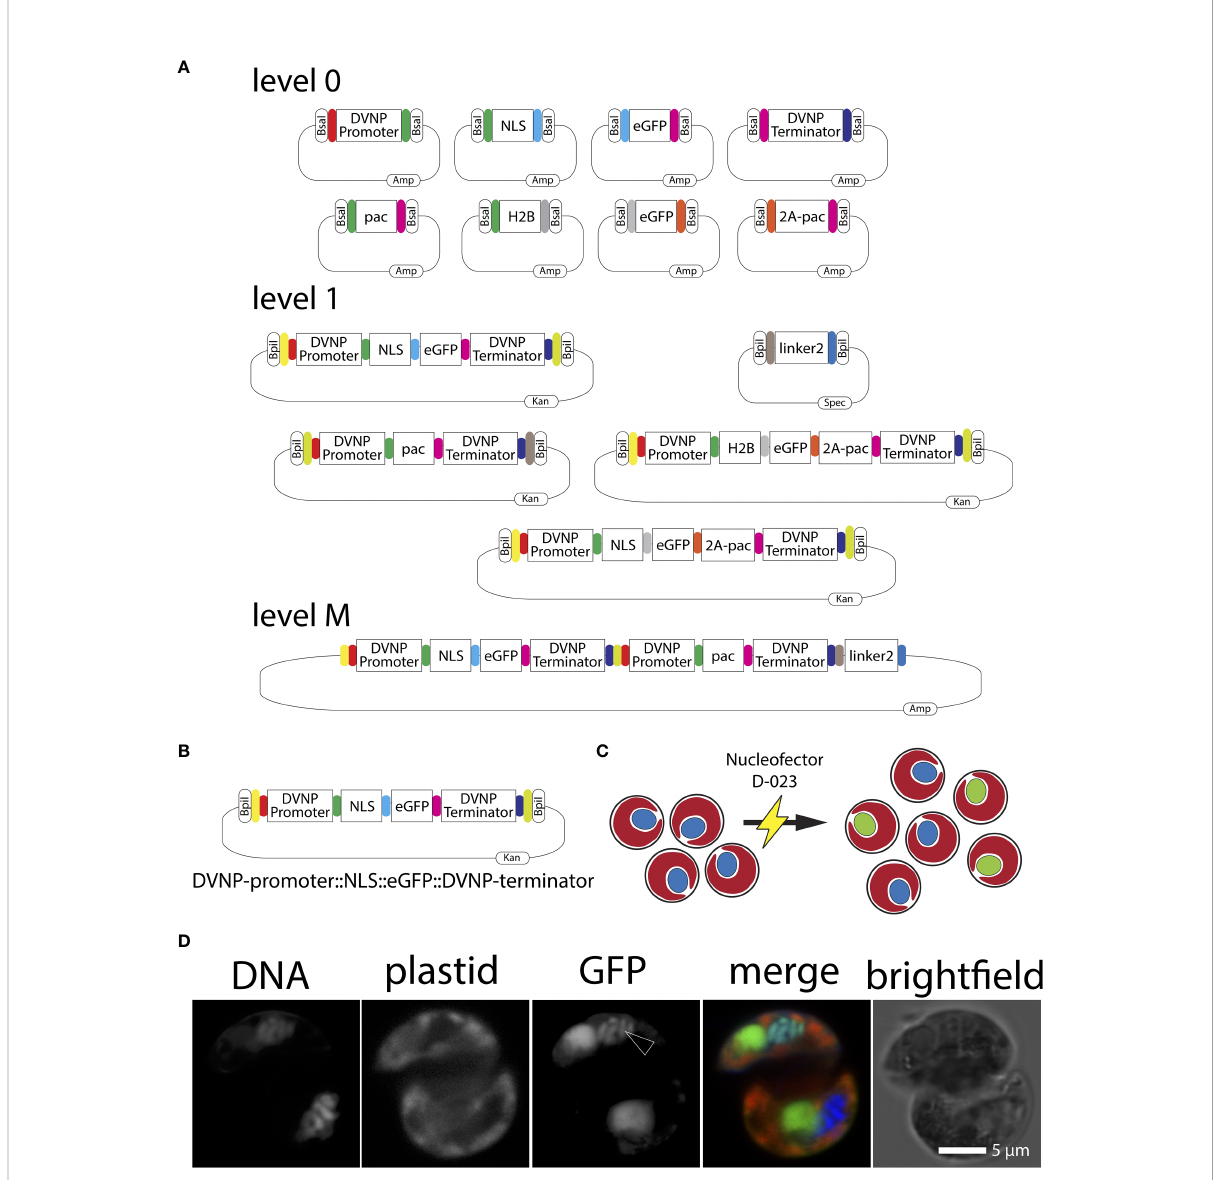
FIGURE 2 (A) Graphical representation of level 0, level 1, end-linker, and level M Golden Gate modules used in this study. Kan=kanamycin, Amp=ampicillin, Spec=spectinomycin. (B) Graphical representation of the DVNP-promoter::NLS::eGFP::DVNP-terminator level 1 position 1 module. (C) Cartoon depicting the Nucleofector electroporation of Breviolum SSB01 cells (red plastid auto- fl uorescence with blue nuclei) and resulting localization of the nuclear targeted NLS-eGFP (red plastid auto- fl uorescence-containing cells with green nuclei) following transformation. (D) Confocal image of a transformed SSB01 cell showing expression and translocation of GFP to the nucleus. Note: all SSB01 cells contain a structure that resembles an accumulation body as described by Wake fi eld et al. (2000). This accumulation body very often sits near the nucleus and exhibits strong auto fl uorescence at 501-550 nm when excited with a 488-nm laser